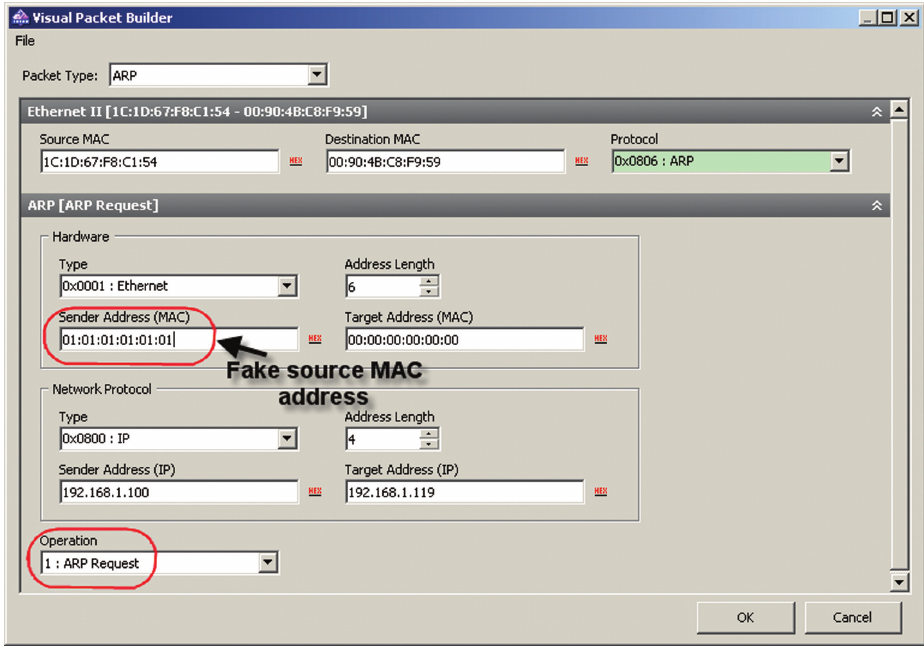
Figure 15. ARP Cache Poisoning Packet Generation Using CommView Visual Packet Builder